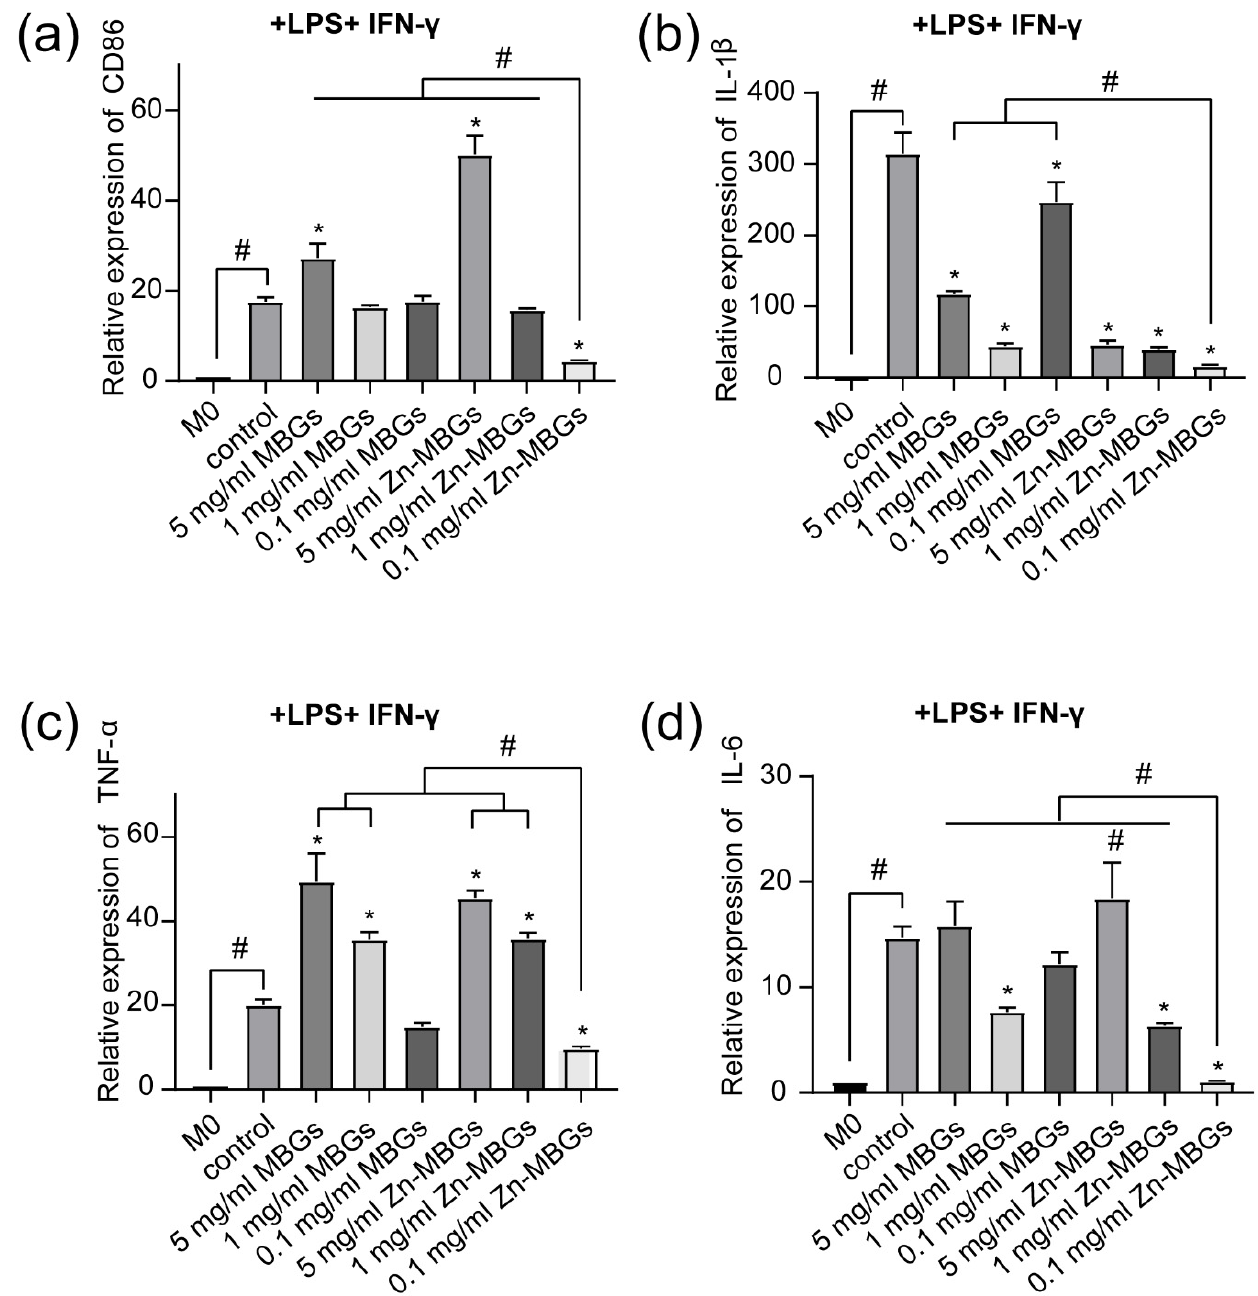
Figure 10. The relative mRNA expression levels of inflammatory cytokines in RAW264.7 after culture with MBGs and Zn-MBGs in the presence of LPS and IFN- γ for 24 h: CD86 ( a ), IL-1 β ( b ), TNF- α ( c ), IL-6 ( d ). M0 was the blank control group, and the Control group was in the M1 state after adding stimulus. Significant difference between the intervention and the control group with * p < 0.05; significant difference between groups with # p <